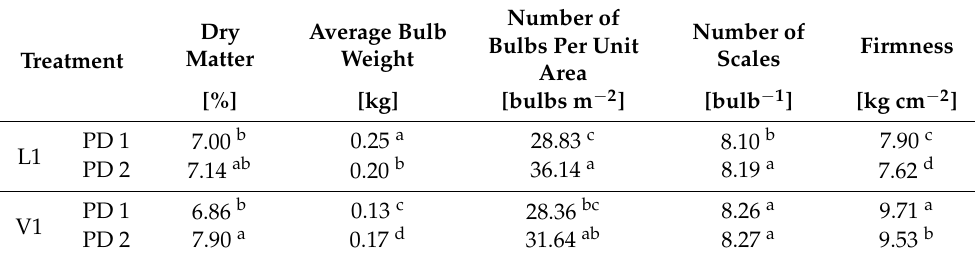
Table 3. Influence of the interaction A × PD on the dry matter percentage, average bulb weight, number of bulbs per unit area, number of scales, and